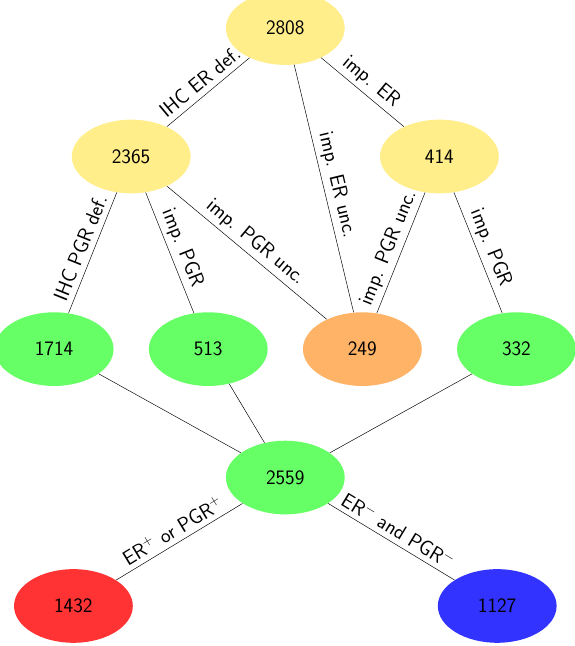
Figure 2. Selection of samples with definite hormone receptor status. Selection started from 2802 samples HER2 − , see Fig. 1. If an IHC estimate for estrogen (ER) was available, ER was considered defined (ER def., 2365). Otherwise the ODDS method 57 was applied, yielding either a safe result (imp. ER, 414) or resulting uncertain (imp. ER unc.), contributing to the set of 249 samples shown in beige. ODDS was applied to the set of 414 samples to impute progesterone status, either safely (imp. PGR, 332, green) or ending up uncertain (imp. PGR unc.), contributing to the beige set of 249. Finally, out of the 2365 samples with IHC available, IHC for progesterone was either available (IHC PGR def., 1714, green), safely imputed by ODDS (imp. PGR, 513, green) or uncertain (imp. PGR unc.), again contributing to the beige set. All in all, IHC receptor status was available for 1714 samples and safely imputed for 513 + 332 = 845 samples. This resulted in 2559 samples with definite hormone receptor status, out of which 1432 were positive (red) and 1127 negative (blue). These constituted the input set for DST, as shown in Fig. 7. Note that no samples exist with PGR IHC defined and ER IHC